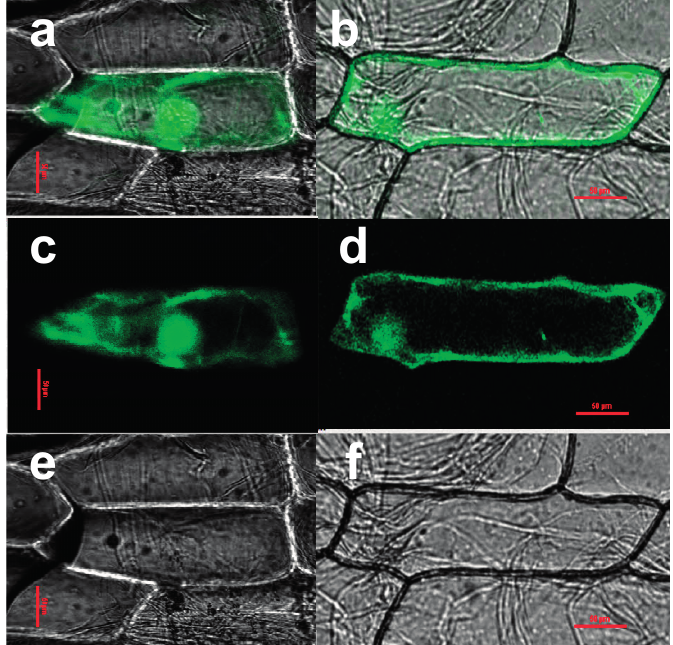
Figure 3. Transient expression of the CaHsp70-1–GFP fusion protein in onion epidermal cells. CaMV35S, a constitutive promoter from the cauliflower mosaic virus. GFP, green fluorescent protein; NOS, nopaline synthase terminator. Transient expression of GFP